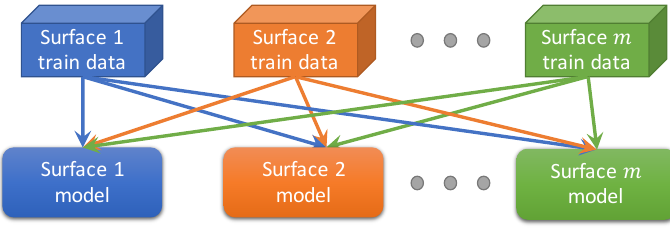
Figure 5. Illustration of the MTL scheme for surface